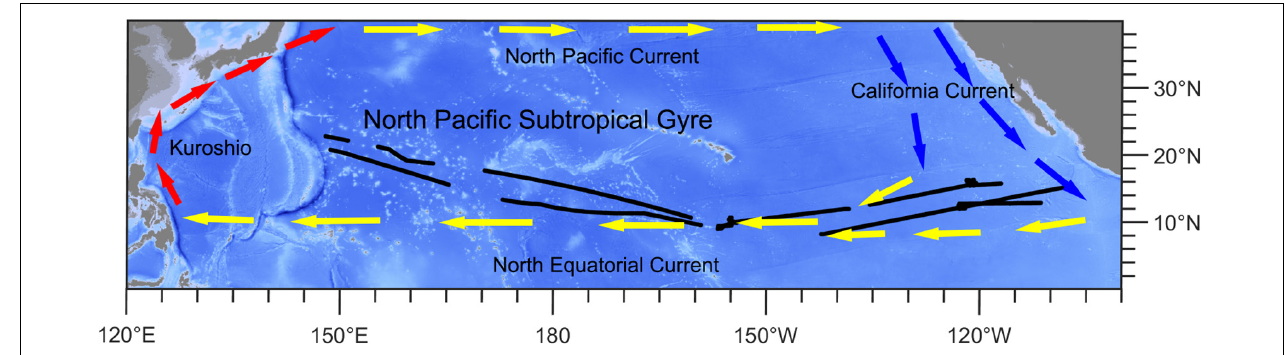
FIGURE 1 | Ship-track (black lines) map of this study. Red arrows show the direction of the Kuroshio Current. Yellow arrows show the directions of the North Equatorial Current and North Pacific Current. Blue arrows show the direction of the California Current.